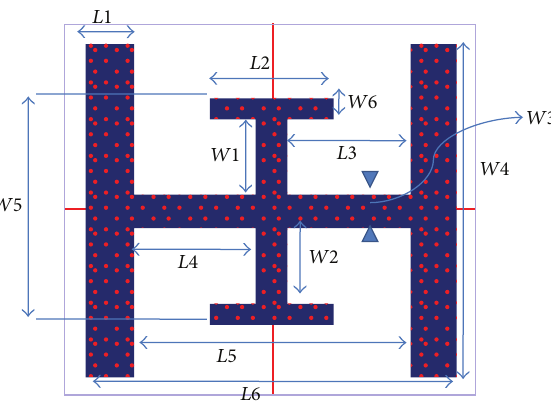
Figure 2: Proposed excitation structure where the feed is to be given.